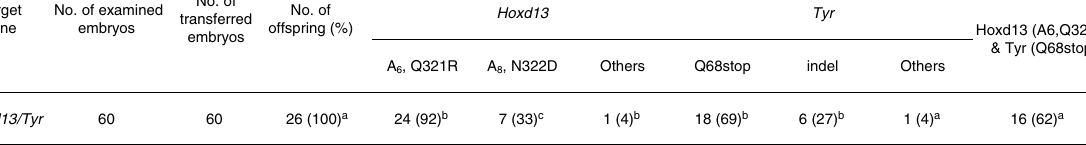
a Calculated from the number of examined embryos. b Calculated from the number of newborns. c Calculated from the number of newborns carrying Q321R conversion. Fig. 3 The generation of Hoxd13 and Tyr mutant mouse models by SaBE3 and SpABE. a Fused digits and white hair phenotypes in founder mice. Left: Mutant mouse shows whole-body white hair and fused digits (purple arrowhead). Right: all the four mice displayed whole-body white hair and fused digits. b Representative alignments of modi fi ed sequences from newborn pups after microinjection of SpABE/SaBE3 mRNA and sgRNAs targeting Hoxd13 and Tyr simultaneously. The PAM sequences and substitutions are highlighted in blue and red, respectively; N/N indicates positive colonies out of the total sequenced. The corresponding targeted codons are shown. c Summary of phenotypes. Three mice displayed normal hair and fused digits; nine mice displayed black-and-white hair and fused digits; four mice displayed whole-body white hair and fused digits; nine mice displayed normal hair and normal digits; one mouse displayed black-and-white hair and normal digits; no mice displayed whole-body white hair and normal digits. d Representative alignments of modi fi ed sequences from newborn pups harboring indel. The PAM sequences and substitutions are highlighted in blue and red, respectively; N/N indicates positive colonies out of the total sequenced. The corresponding targeted codons are shown. e Summary of the genotyping of Hoxd13 and Tyr mutations of newborns by SaBE3 and SpABE-mediated base